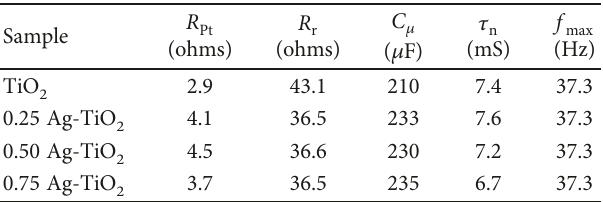
Figure 7: (a) Nyquist plot and (b) Bode-plot of DSCs based on photoanodes nano-Ag-TiO Table 4: Cathode charge transfer resistances ( R ) of DSCs measuring at V recombination resistances ( R r sun